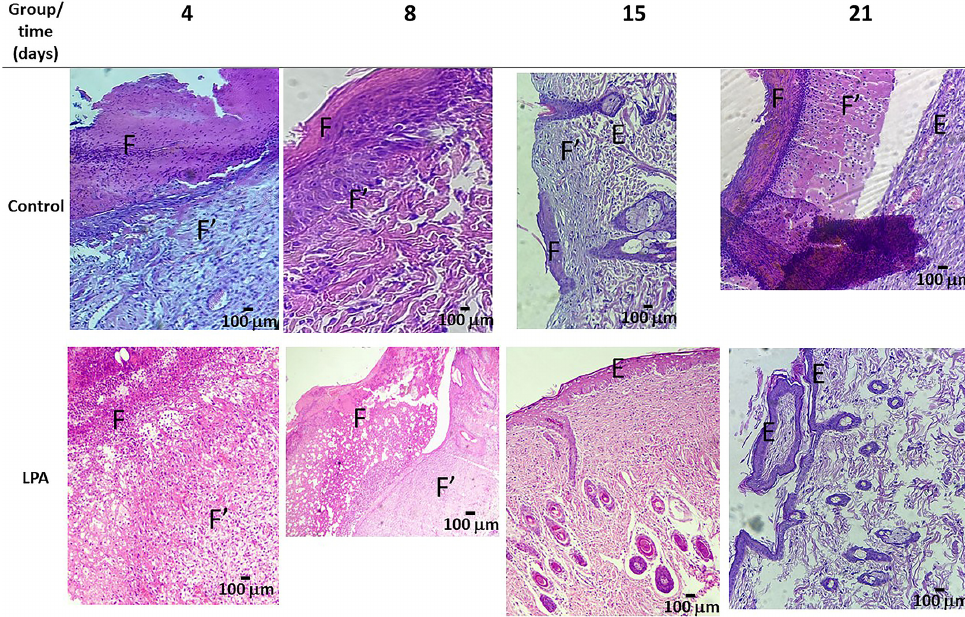
Figure 6. Images of the tissue during the healing process. F = fi brin, F ′ = dense fi brous tissue, E = epidermis. Hematoxylin & eosin stain, 10×.